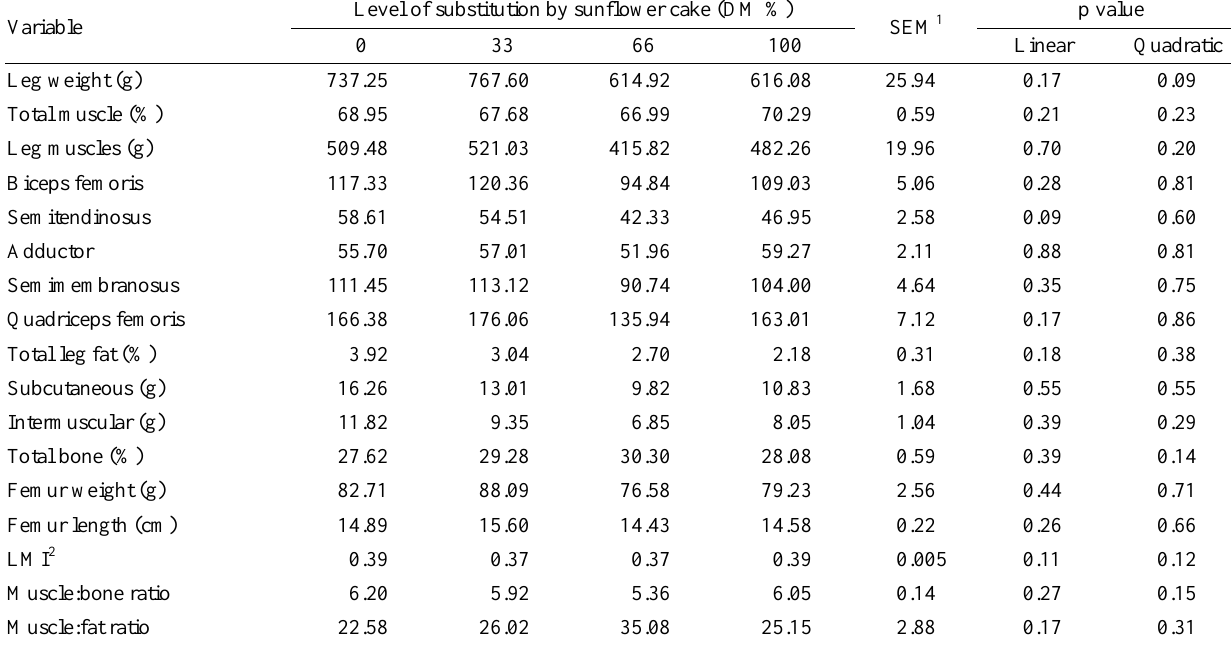
Table 6. Tissue compositions and leg muscularity index of 1/2 Boer kids fed diets containing sunflower cake Variable